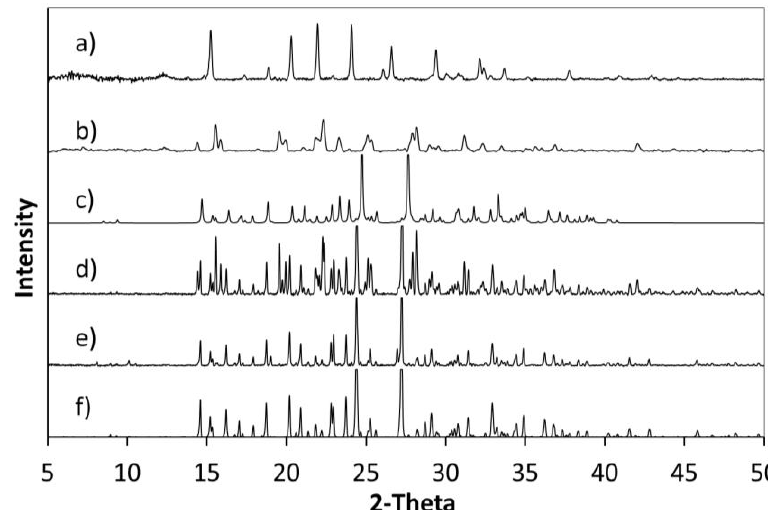
Figure 15. PXRD analysis of cooling crystallisations carried out using the Crystal16 apparatus: ( a ) 5FC; ( b ) 4Cl35DNBA form II; ( c ) 5FC-4Cl35DNBA 5FC:4Cl35DNBA in ethanol:water (7:3 by volume) in ( d ) a 1:2 starting material ratio (0.5 °C min −1 ); ( e ) a 1:2 starting material ratio (2 °C min −1 ) and ( f ) a 1:1 starting material ratio (2 °C min −1